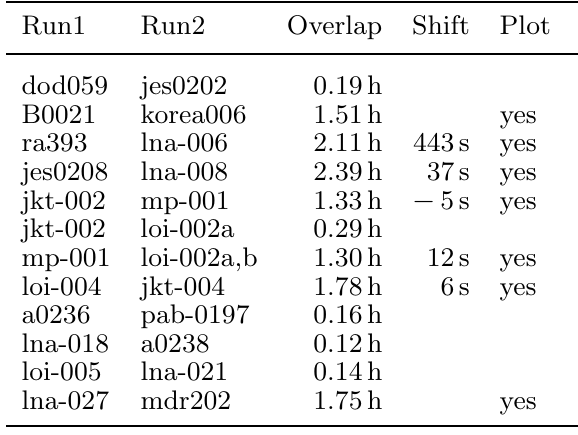
Table 4. Overlapping data sets and rela- tive time